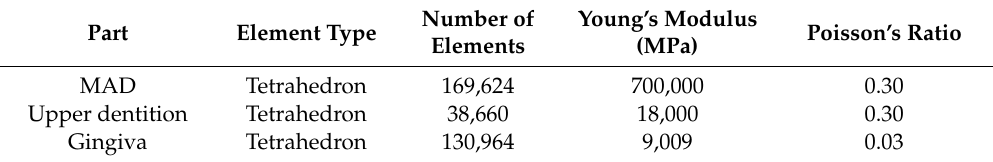
Figure 3. Finite element (FE) modeling of MAD with upper dentition: ( a ) conventional, ( b ) proposed, and ( c ) boundary condition. Table 1. Material properties of MAD, upper dentition, and gingiva.